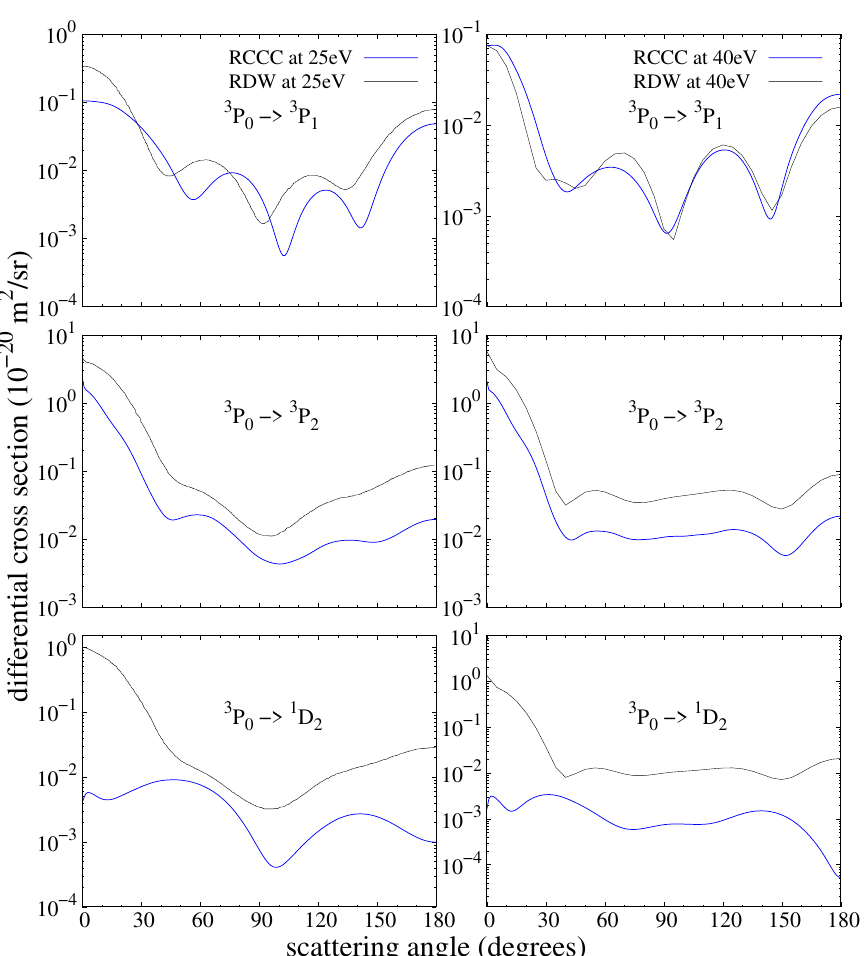
Figure 7. RCCC differential cross sections for excitations to the first three low-lying levels in the 5 p 2 manifold from the ground state. Comparison is shown with the RDW results of Srivastava et al.